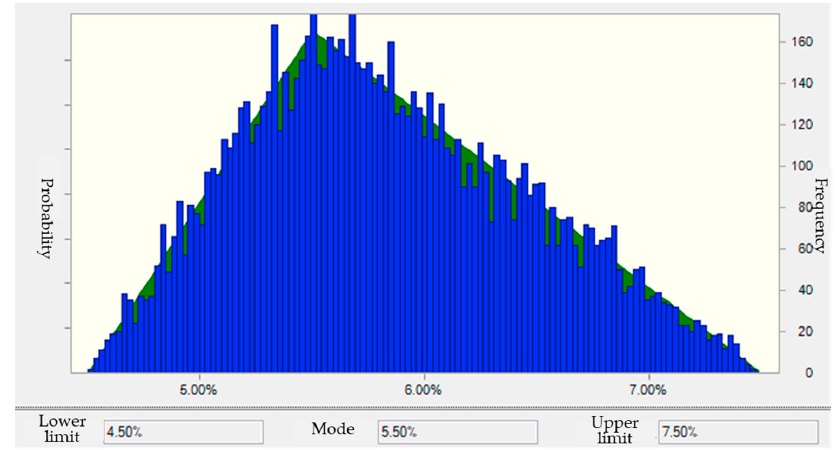
Figure 3. Probability distribution for discount rate (triangular distribution).